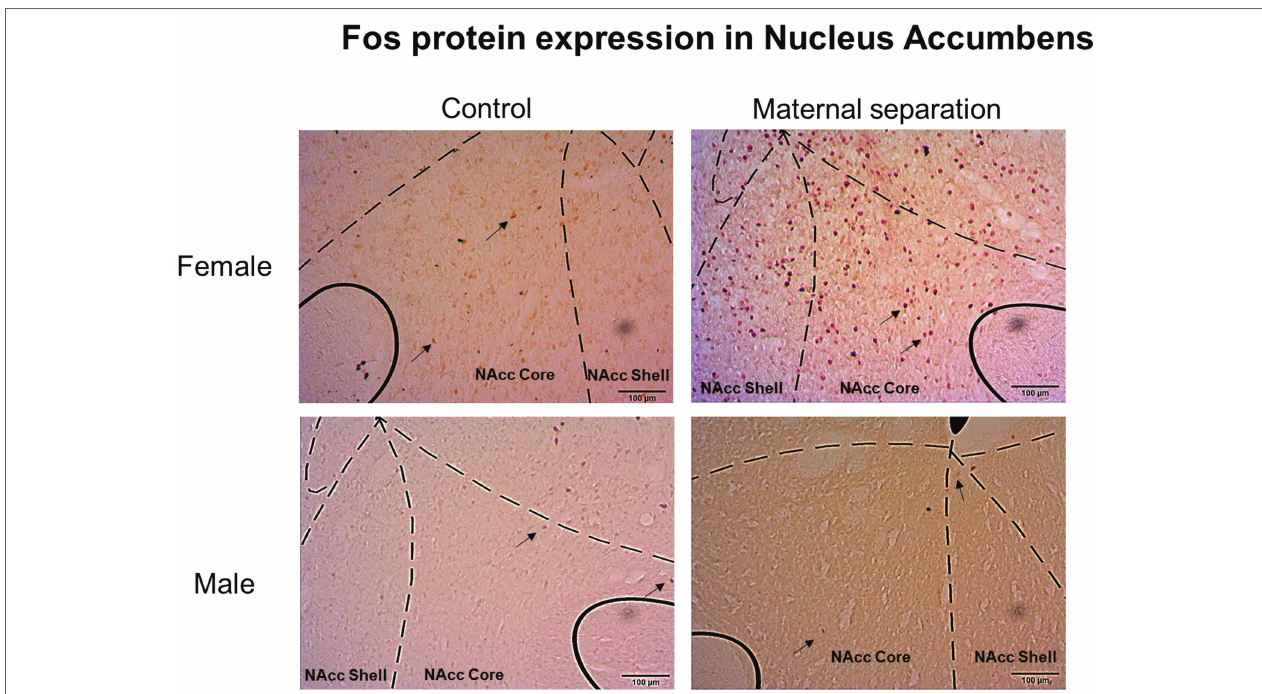
FIGURE 5 | Fos protein expression in nucleus accumbens (Nacc) Core and Shell. Images represent Fos positive cells in Nacc Core and Shell of female and male mice submitted to MS and control group. Black arrows indicate Fos-immunoreactive neurons (Fos-IR) neurons. Coordinates for Nacc: 1.18 mm anterior to bregma (Paxinos and Franklin,